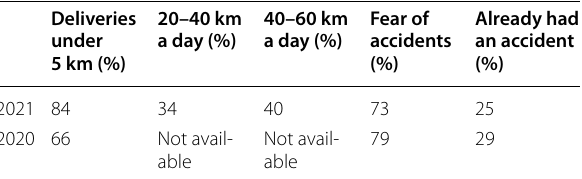
Table 5 Kilometers per day and accidents in 2021 and 2020.